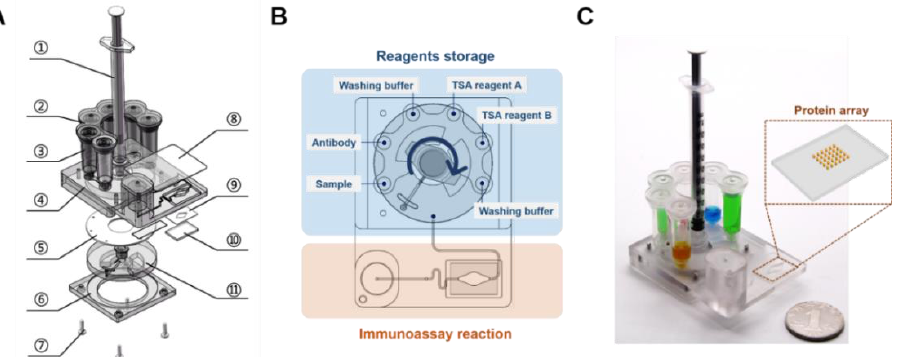
Figure 1. Schematic of the cassette used for the immunoassay. ( A ) The three-dimensional illustration of the cassette in an exploded view, 1. Luer syringe; 2. lid; 3. reagents and waste storage chambers; 4. main body of the cassette; 5. polyurethane washer; 6. cassette base; 7. screws; 8. pressure-sensitive adhesive (PSA) cover slip; 9. double adhesive tape; 10. glass; 11. rotary valve. ( B ) Schematic layout of the microfluidic cassette indicating various features. The blue area represents the reagent storage module, and the yellow area represents the immunoassay reaction module. ( C ) Photo of the cassette. The yellow box shows the glass with a protein microarray.